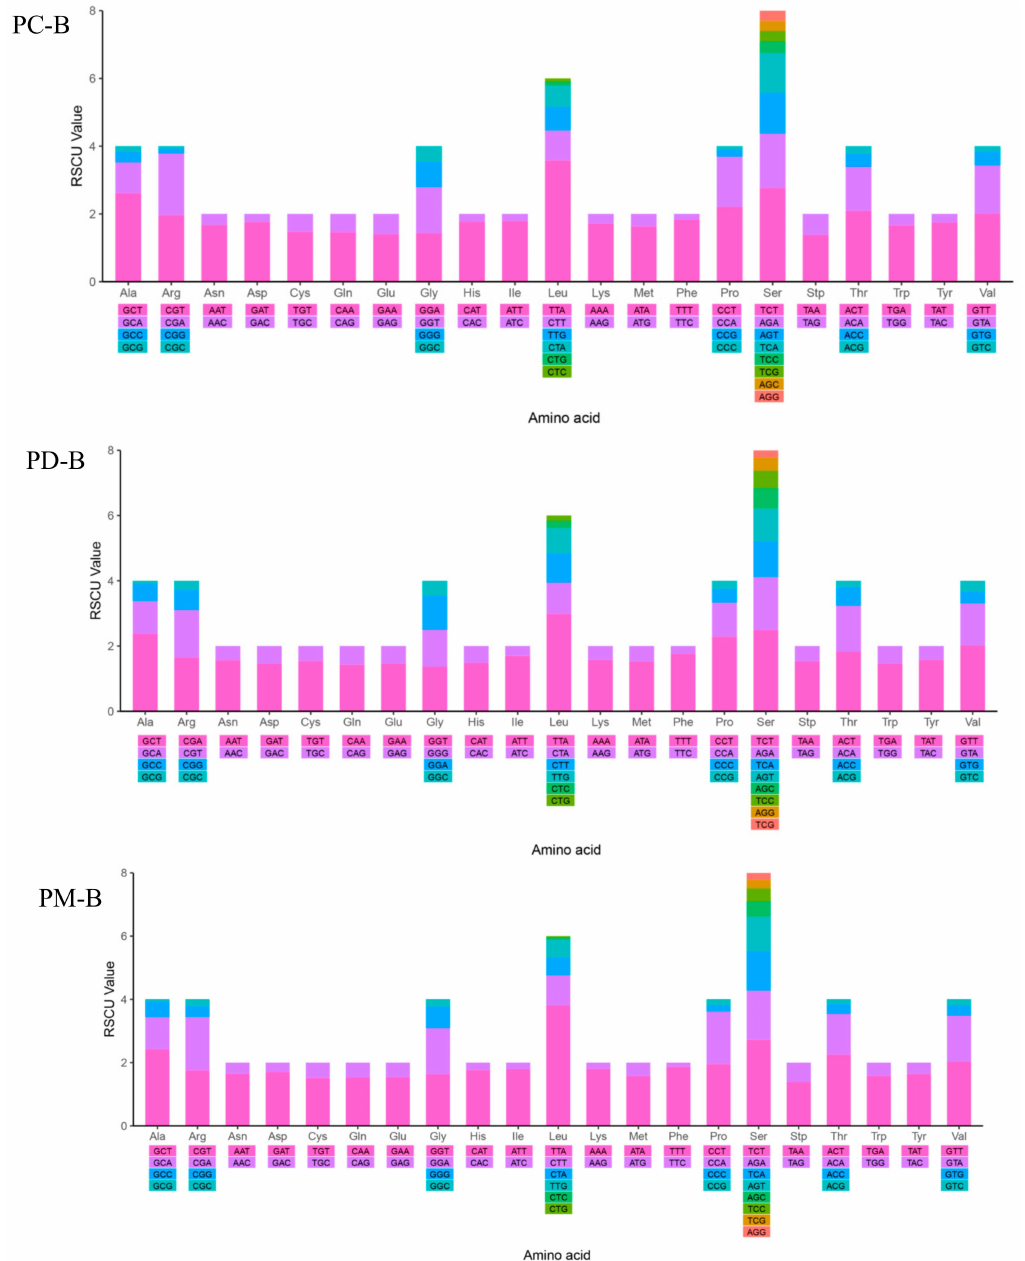
Figure 5. Codon Frequency ( A ) and RSCU ( B ) in the mitochondrial genomes of P. canaliculata ( PC ), P. diffusa ( PD ) and P. maculate ( PM ). PC-A indicated the Codon Frequency of P. canaliculata ; PD-A indicated the Codon Frequency of P. diffusa ; PM-A indicated the Codon Frequency of P. maculate . PC-B indicated the RSCU of P. canaliculata ; PD-B indicated the RSCU of P. diffusa ; PM-B indicated the RSCU of P. maculate